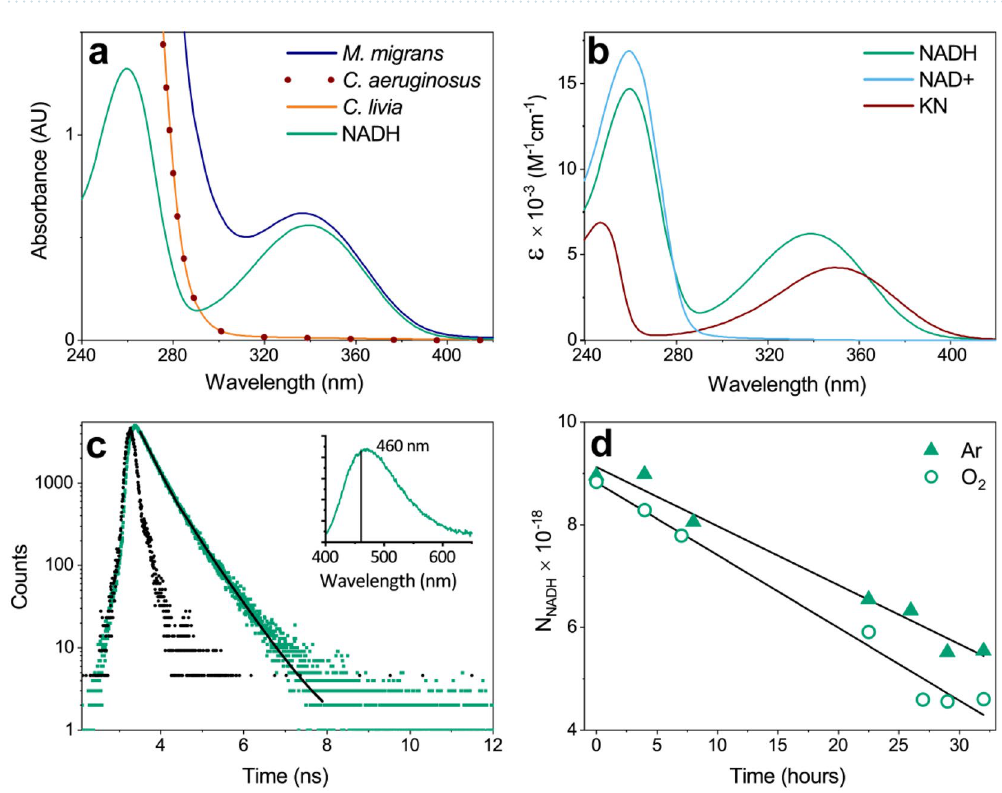
Figure 4. ( a ) UV–Visible spectra of bird lens metabolomic extracts in aqueous solution and the spectrum of 0.08 mM NADH aqueous solution; ( b ) Optical absorption spectra of NADH, NAD + and KN; ( c ) Kinetics of NADH fluorescence decay (green dots), measured at λ em = 460 nm, convolved with IRF (black dots) and fitted by a biexponential function (black line); insert: a steady-state fluorescence spectrum of NADH; ( d ) Kinetics of NADH photodecomposition (in units of number of molecules in 3 mL of aqueous solution) during 300–400 nm photolysis under Ar and O 2 with the correction on the solvent evaporation during the